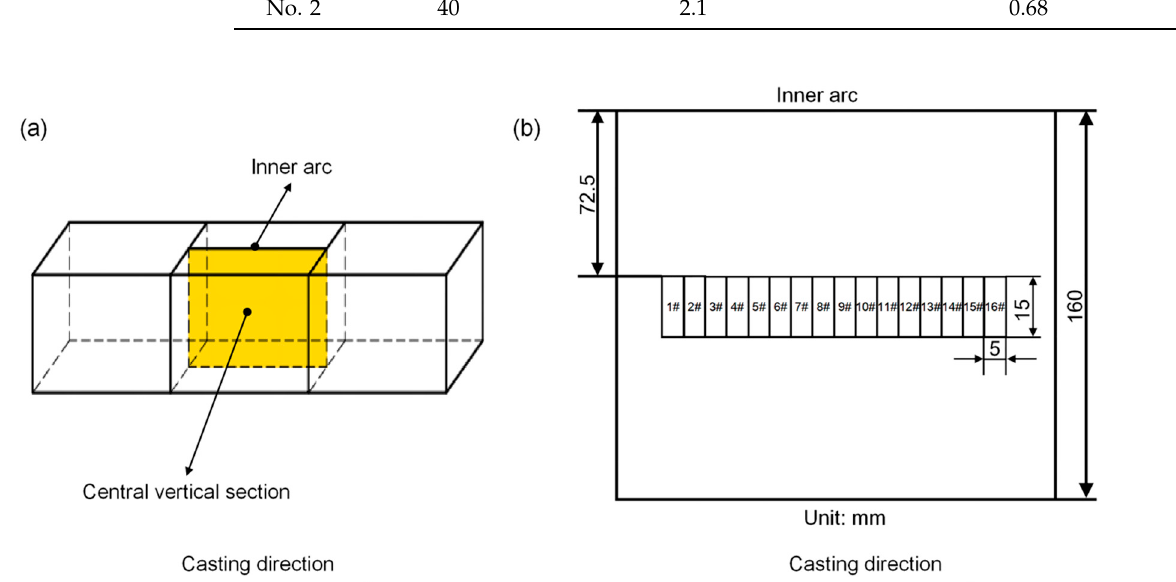
Figure 1. Schematic of central vertical section and analysis areas in continuous casting billet. ( a ) Two billet samples under different process parameters were cut along the centerline from inner arc side to outer arc side and the obtained central vertical sections were taken as the research objects. ( b ) For the obtained central vertical sections, 16 analysis areas were selected along the casting direction in the central equiaxed crystal zone. The size of each analysis area is 5 mm × 15 mm.